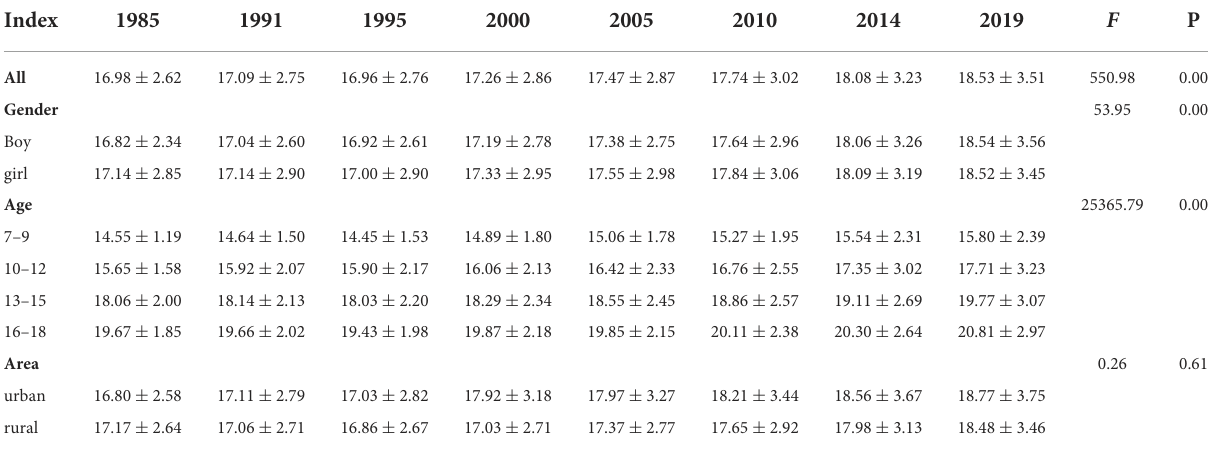
TABLE 2 The mean BMI of survey children from 1985 to